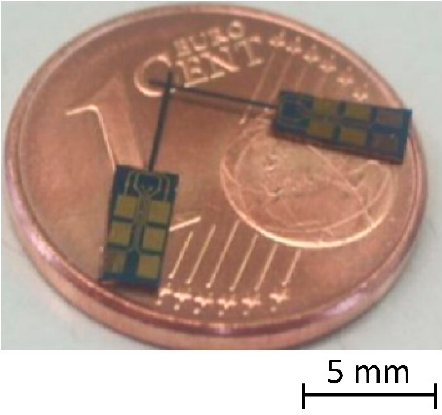
Figure 1. Two 5-mm long piezo-resistive silicon microprobes with integrated silicon tip on a 1 Euro Cent coin.